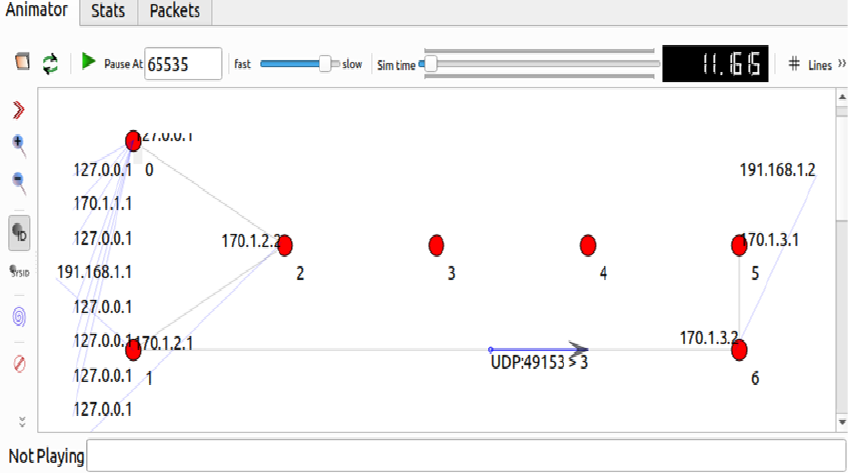
Figure 9. SCN design using ns-3.